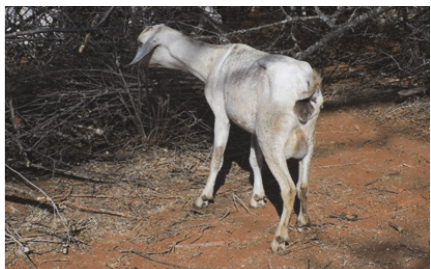
Figure 3: Suspect PPR case of a goat in Wajir.